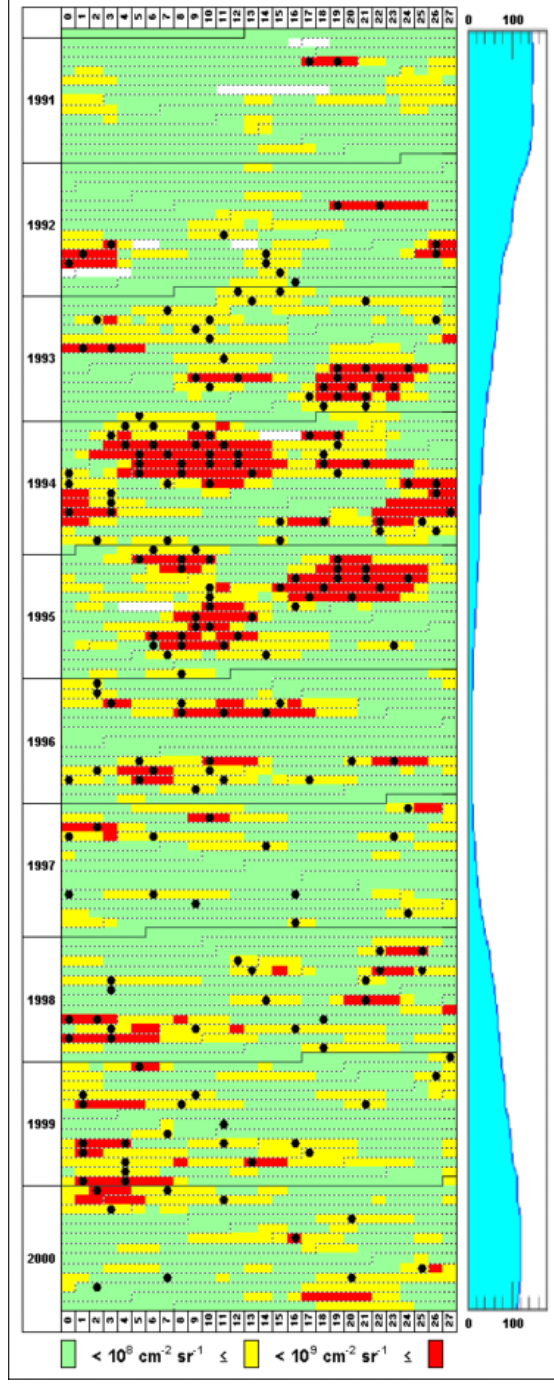
Fig. 1. (a) 2-day fluence of > 2MeV electrons at GEO showing 214 correlated phantom commands. (b) smoothed sunspot number from January 1991 to December 2000.